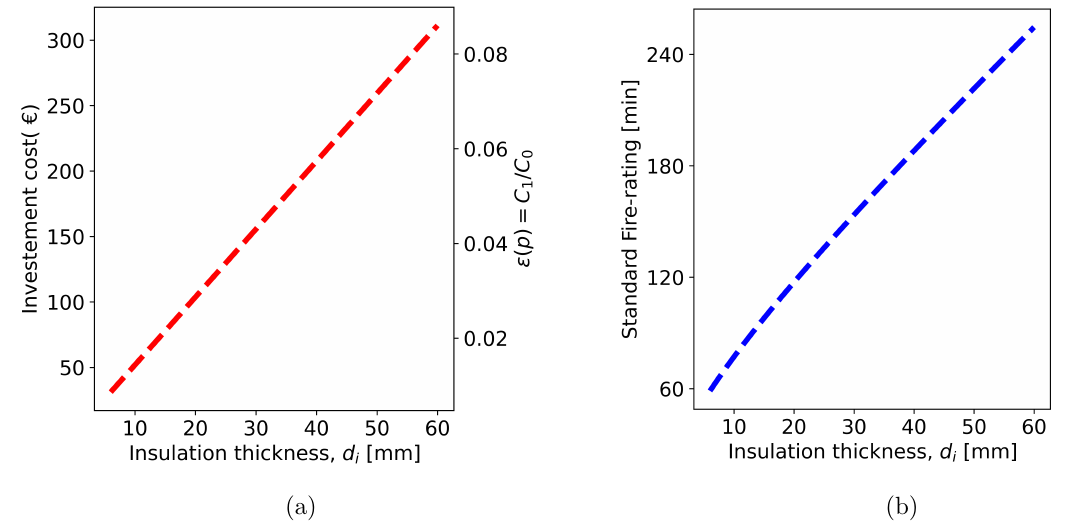
Figure 1. (a) Cost of SFRM insulation of steel column. (b) Relationship between SFRM insulation thickness and standard fire-rating of the steel column (based on ISO 834 criteria) Stochastic variables Distribution Mean COV Material properties, SFRM [14]